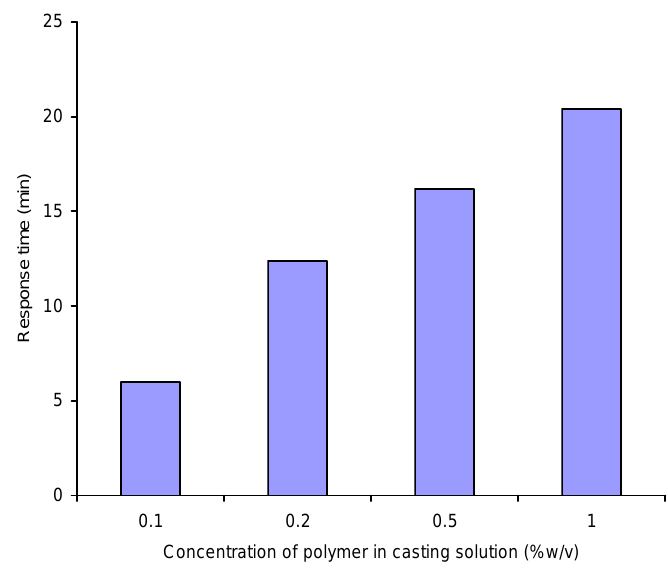
Figure 3. The effect of polymer concentration of casting solution (polymer thickness) on response time of polystyrene-modified quartz crystal electrode exposed to 15 mg l − 1